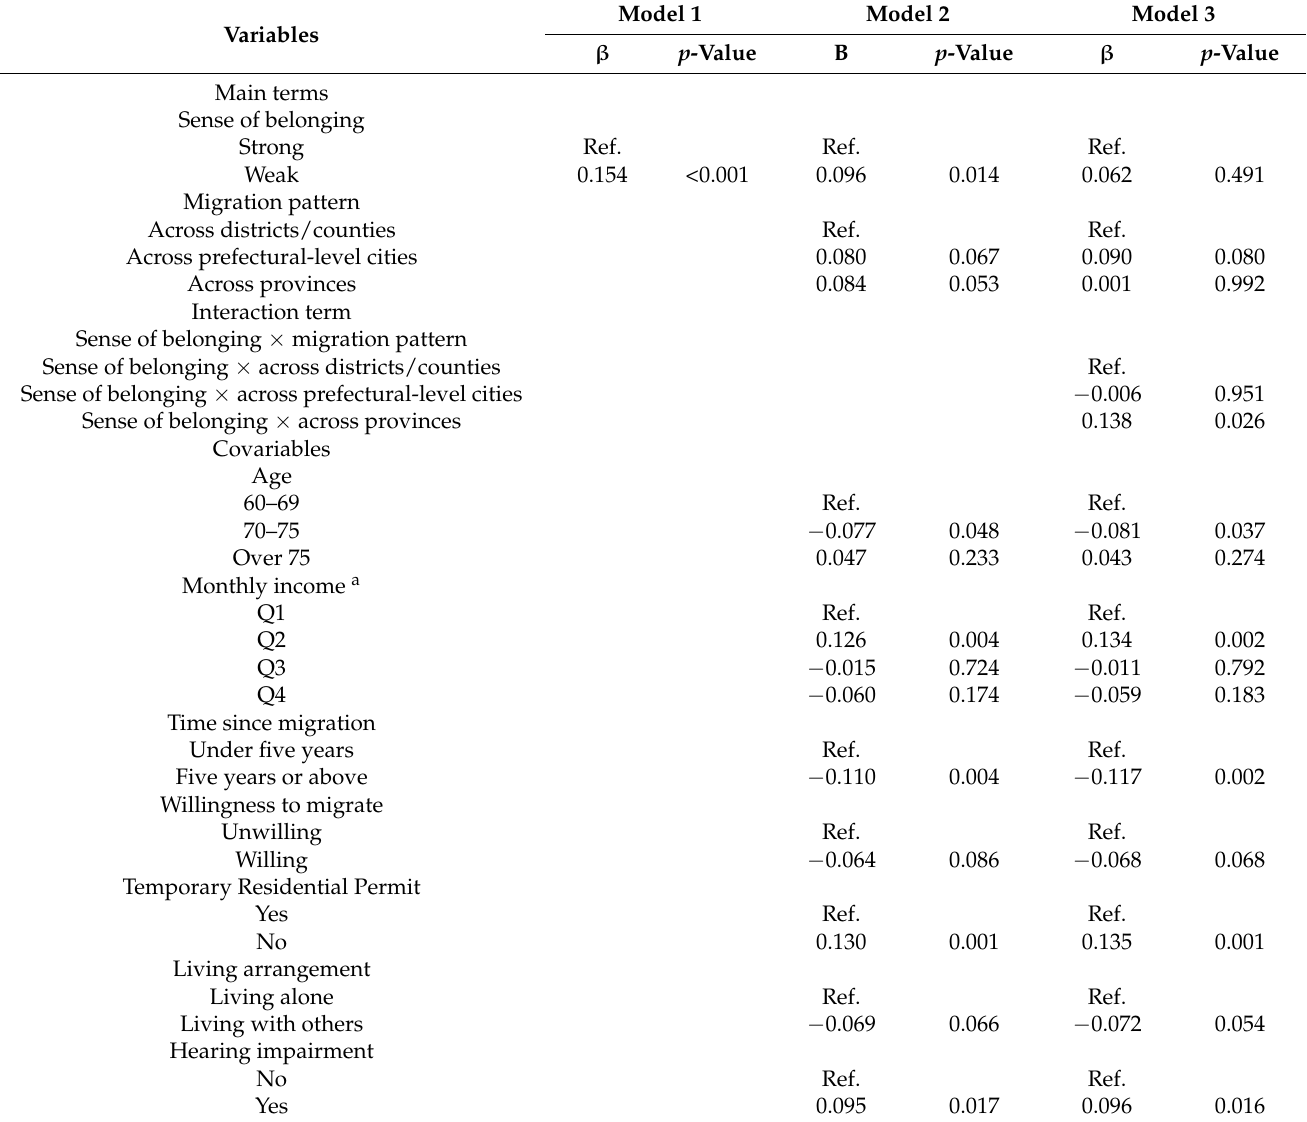
Table 2. Association between sense of belonging and loneliness among the MEFC in Jinan, Shandong Province,